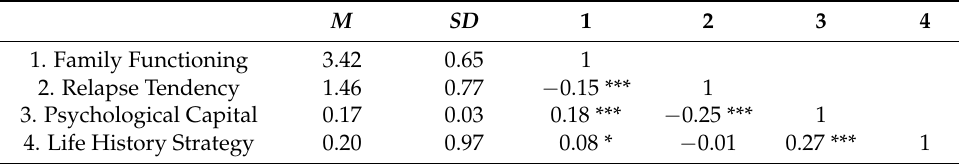
Table 2. Means, standard deviations, and correlation matrix of all